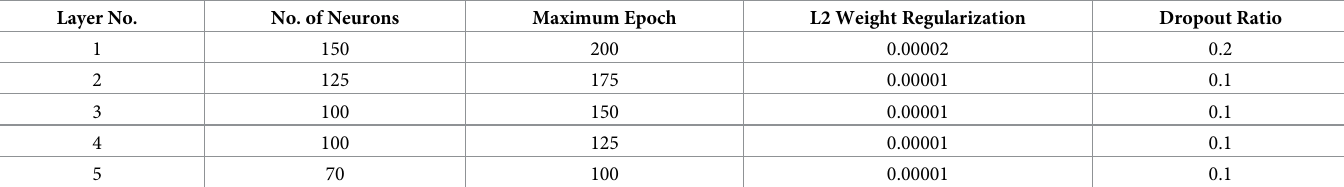
Table 2. Precise fine-tuned parameters for Offshore Windfarm 1. Layer No.